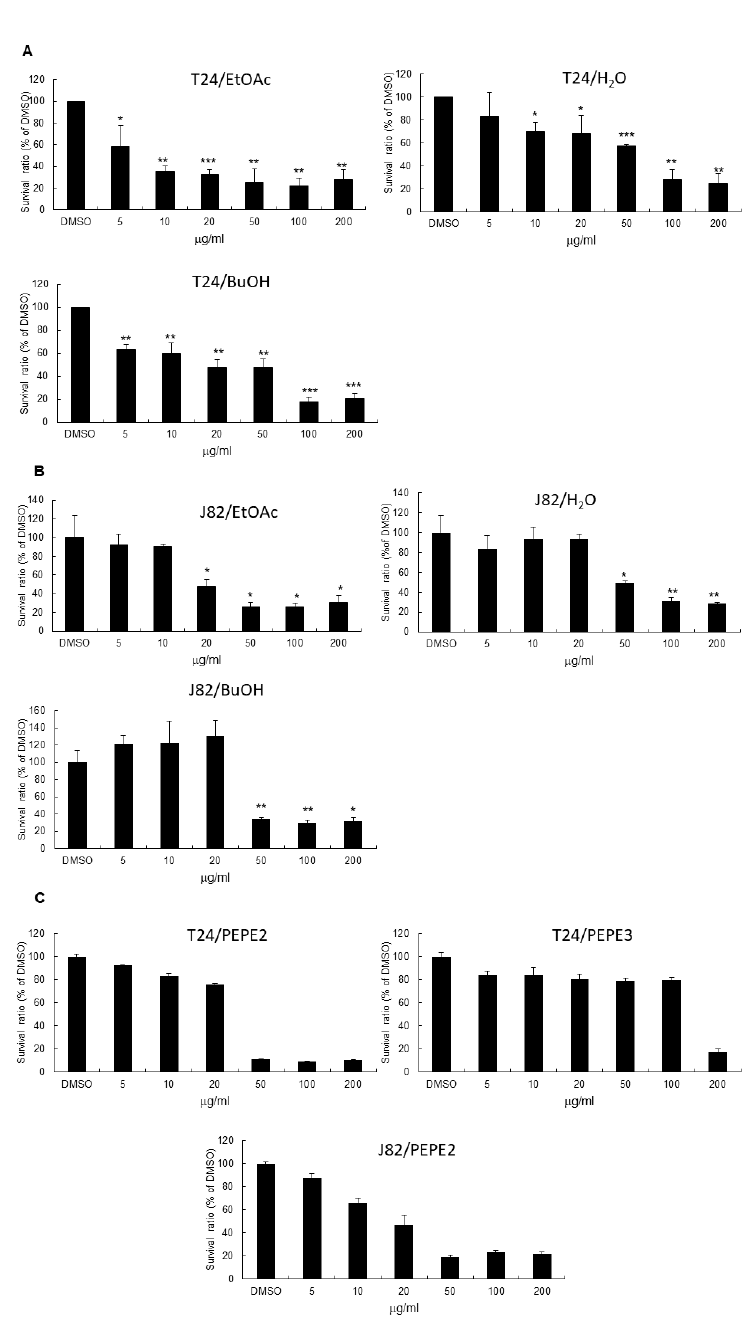
Figure 1. The inhibitory activities of Taiwanese local pomegranate fruit. The ethylacetate, butanol, and water layers extracted from pomegranate peel extract (PEP) were tested for the inhibitory efficacy to T24 ( A ) or J82 ( B ) cells using MTT assay as described in Materials and Methods. PEPE2 and PEPE3 ( C ) were also investigated for the inhibitory effectiveness to T24 or J82 cells. 0.1% ( v / v ) Dimethyl sulfoxide (DMSO)-treated urinary bladder urothelial carcinoma (UBUC) cells were regarded as the solvent control. Each MTT result was the typical data of at least three independent experiments. * p ≤ 0.05, ** p ≤ 0.01, *** p ≤ 0.001.